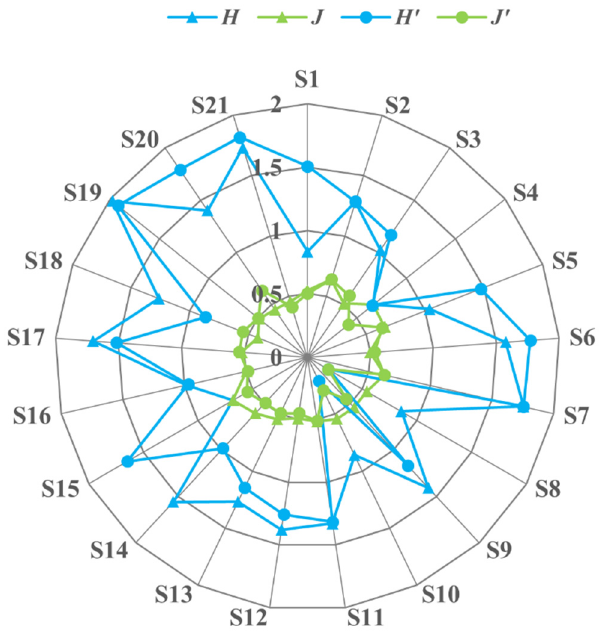
Figure 3. Fish biodiversity index of each sampling point. Note: The code information of the sampling points is shown in Table 1. Index of diversity in the wet season: H − Shannon index and J − Pielou evenness index; index of diversity in the dry season: H’ − Shannon index and J’ − Pielou evenness index.